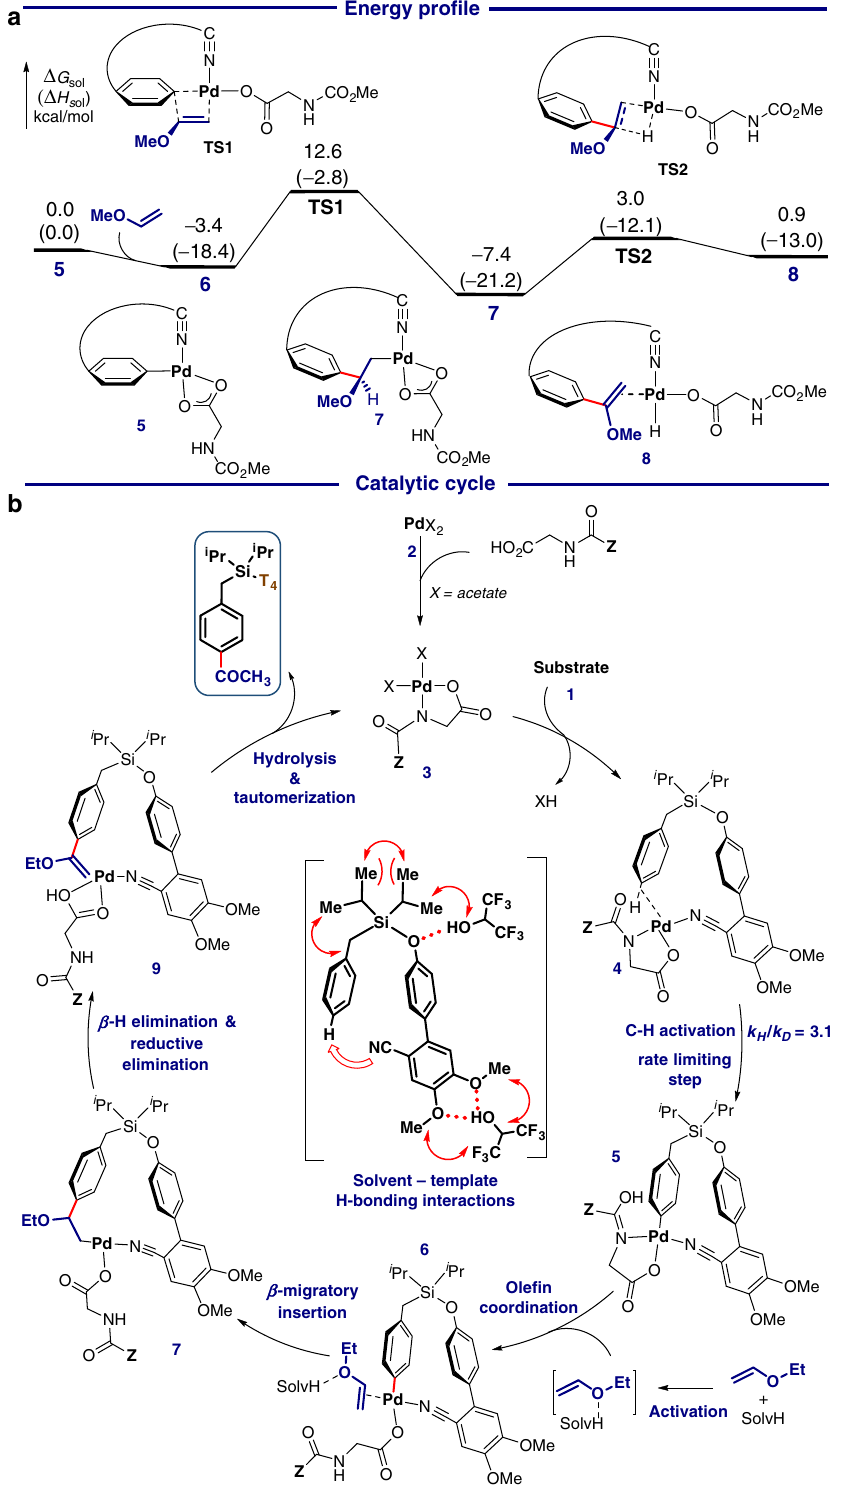
Fig. 5 Stepwise mechanism of para -ketonisation. a Energy pro fi le of the para -C − H acylation with vinyl methyl ether. Energies are with respect to the palladacycle 5 . See SI for the complete energy pro fi le. Method: M06/SDD-6-311 + G(d,p)/ SMD(HFIP)//B3LYP/SDD-6-31G(d). b Plausible catalytic